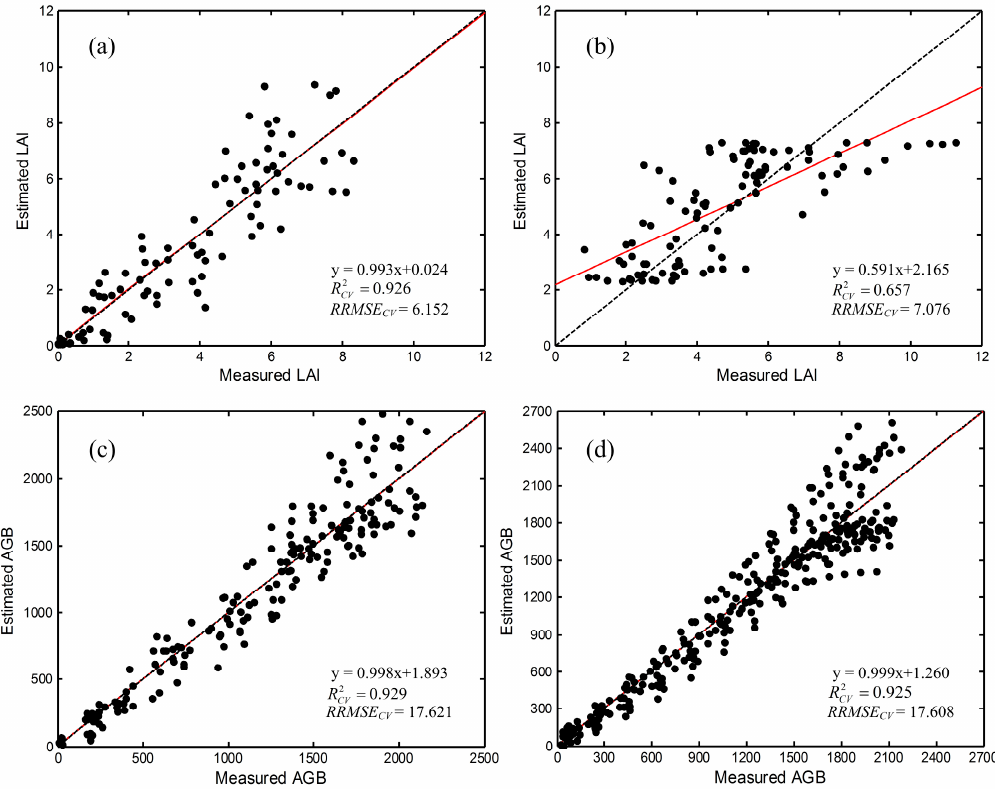
Figure 4. Relationships between measured rice leaf area index (m 2 /m 2 ) and dry aboveground biomass (g/m 2 ) at different rice growth stages with VIs. ( a ) Before heading LAI estimation using EVI2-BPNN regression; ( b ) after heading LAI estimation using NDVI-SVM regression; ( c ) all-growth stage AGB estimation using daily cumulative NDVI and based on the quadratic polynomial fit function; ( d ) all-growth stage AGB estimation using 10-day composite data and based on the cumulative NDVI quadratic polynomial fit function. The black dash lines are the 45° lines, and the red solid lines are the linear regression trend lines.